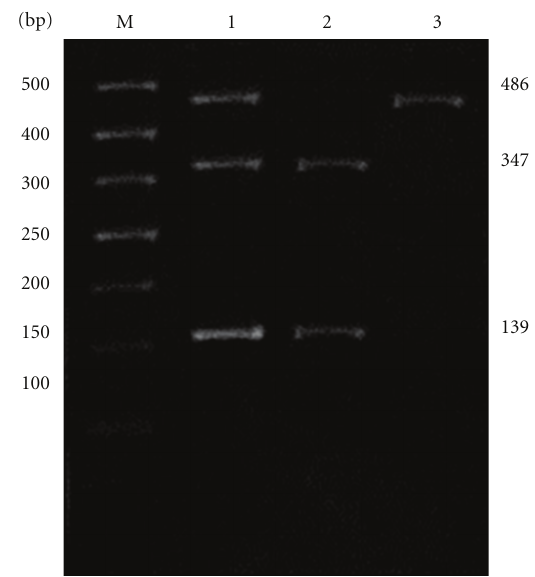
Figure 2: PCR restriction fragment length polymorphism results of − 1661 A to G substitution in CTLA-4 promoter region.(1) AG genotype; (2) AA genotype; (3) GG